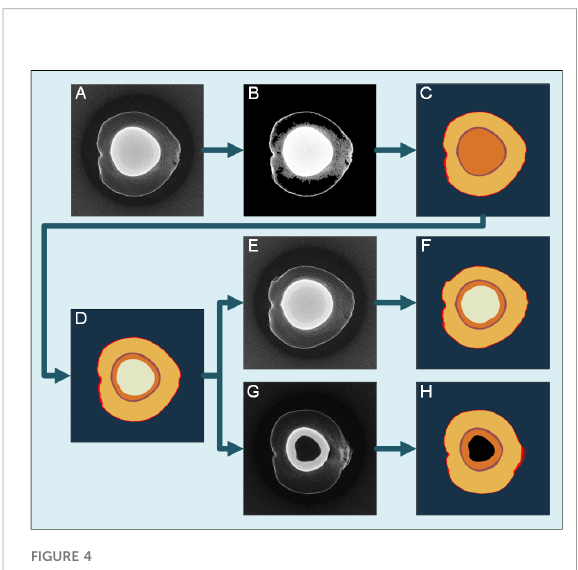
FIGURE 4 fl ow chart of traditional image processing segmentation